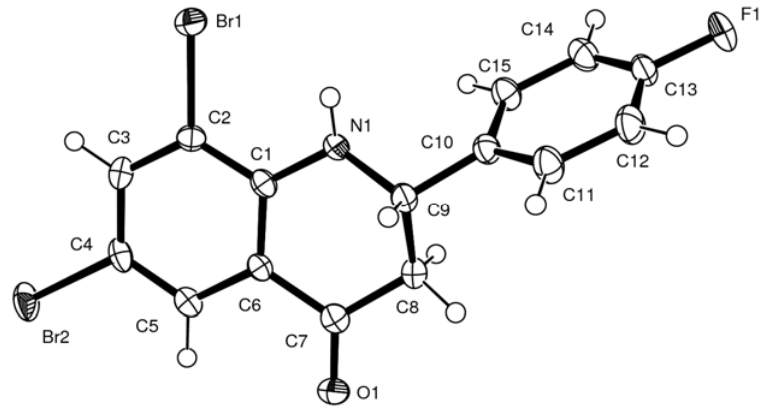
Figure 1. X-ray crystal structure of 6,8-dibromo-2-(4-fluorophenyl)-2,3-dihydroquinolin- 4(1 H )-one ( 3b ) showing crystallographic numbering. For clarity, hydrogen atoms are not